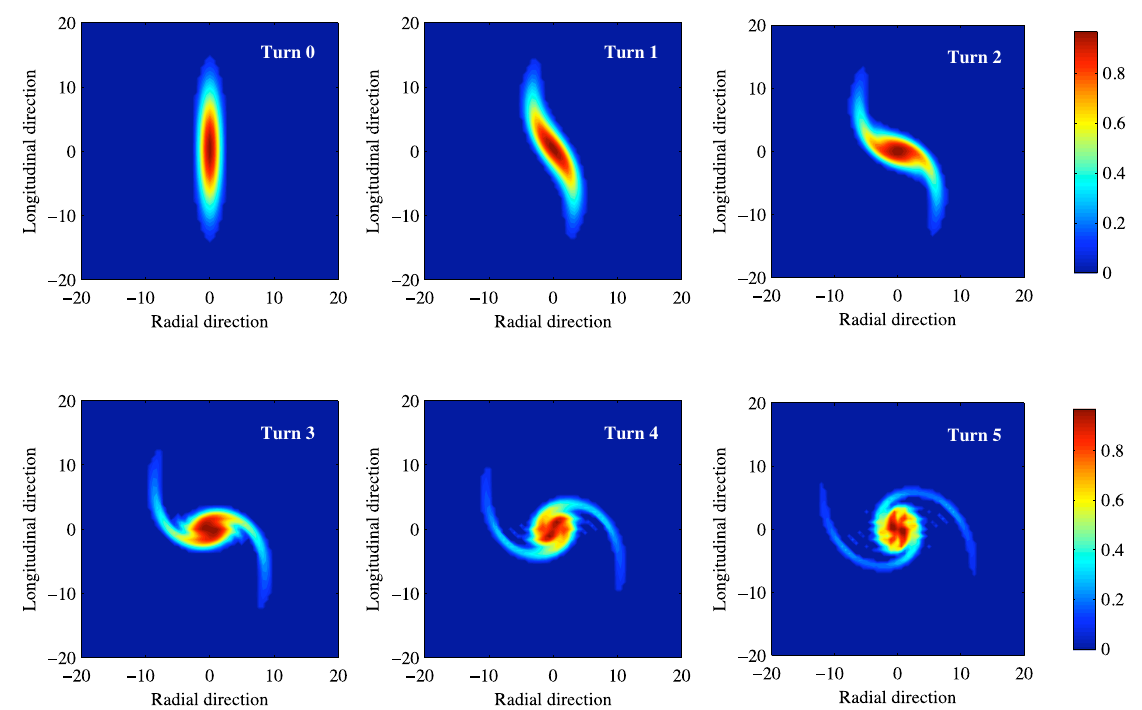
FIG. 6. Top view of an elongated coasting beam in the local frame moving with the beam center. Up: turn 0, 1, 2. Down: turn 3, 4, 5. To compare with figures in Refs. [3,18], the beam’s transport direction is along the negative y direction. (cid:4) 2 ¼ 0 : 8 , 2 (cid:9) x ¼ 2 : 52 mm , and 2 (cid:9) y ¼ 13 : 4 mm .